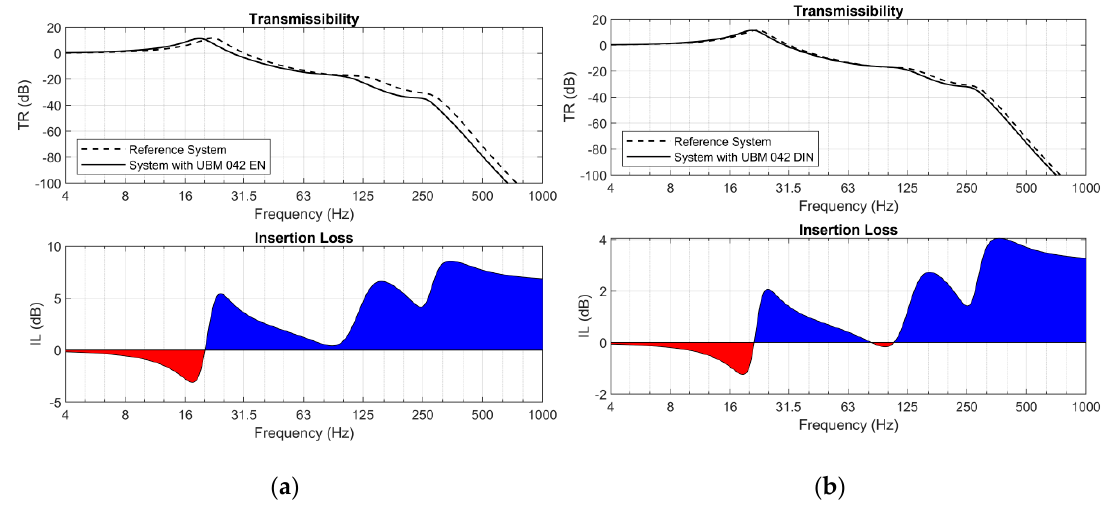
Figure 12. Transmissibility (TR) and insertion loss (IL)—reference system and system with UBM 042: ( a ) according to EN [24]; ( b ) according to DIN [23].